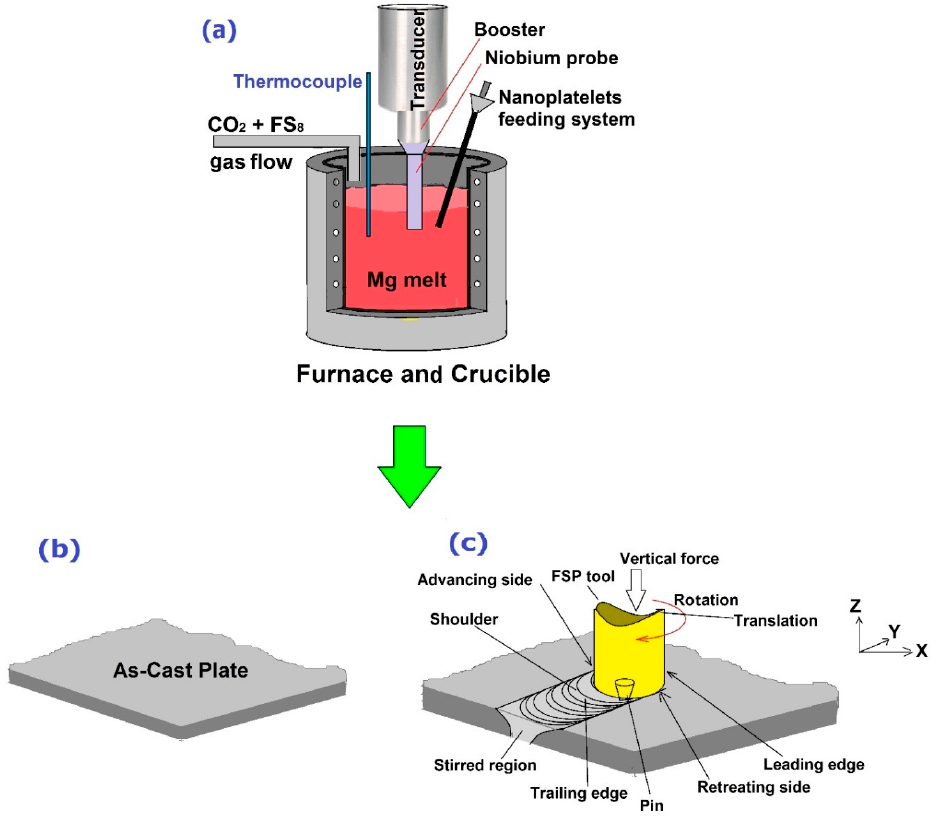
Figure 8. Schematic of the processing procedure for fabricating Mg-graphene composite ( a ) stir casting, ( b ) as plate and ( c ) Friction stir processing (FSP) reproduced from [90], with permission from Elsevier, 2012.